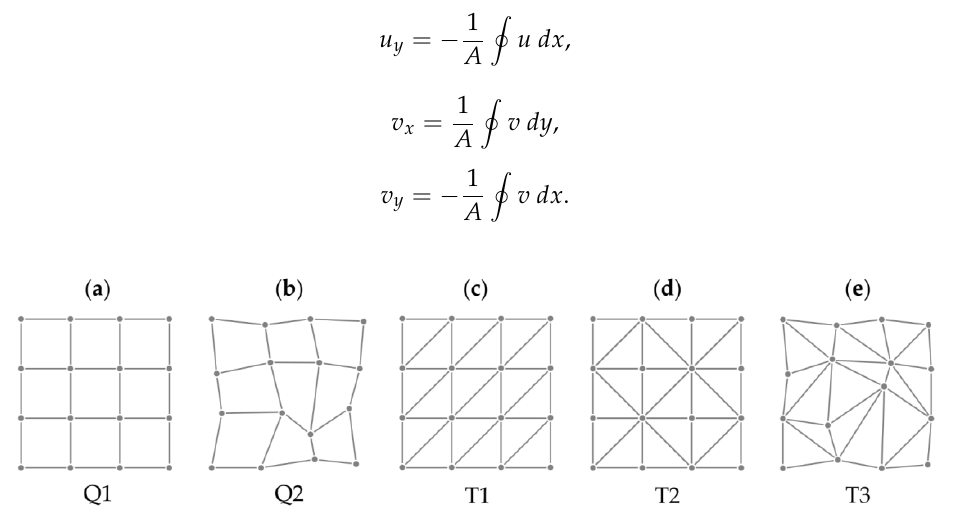
Figure 2. Regular ( a ) and irregular ( b ) deformation grids of squares. For triangles, three different constellations used in our study are shown: regular (( c ) and ( d )) and irregular ( e ). The positions of grid vertices correspond to the origins of the drift vectors.